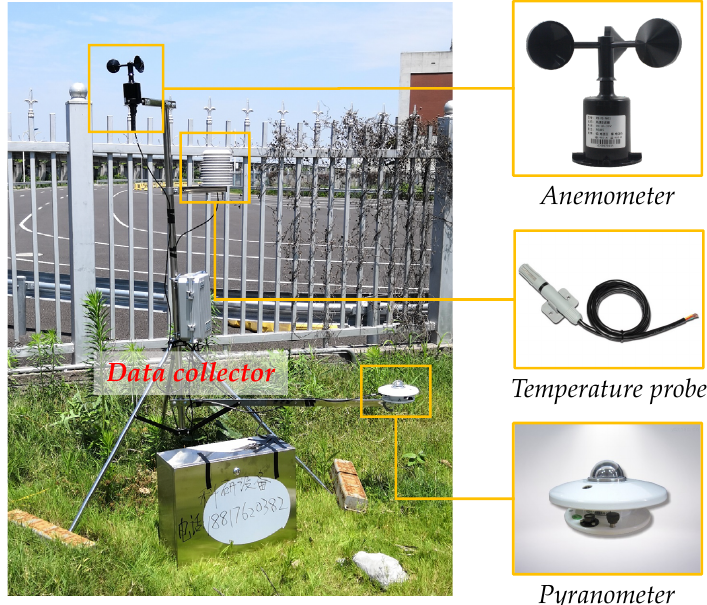
Figure 10. Composition of the meteorological station.